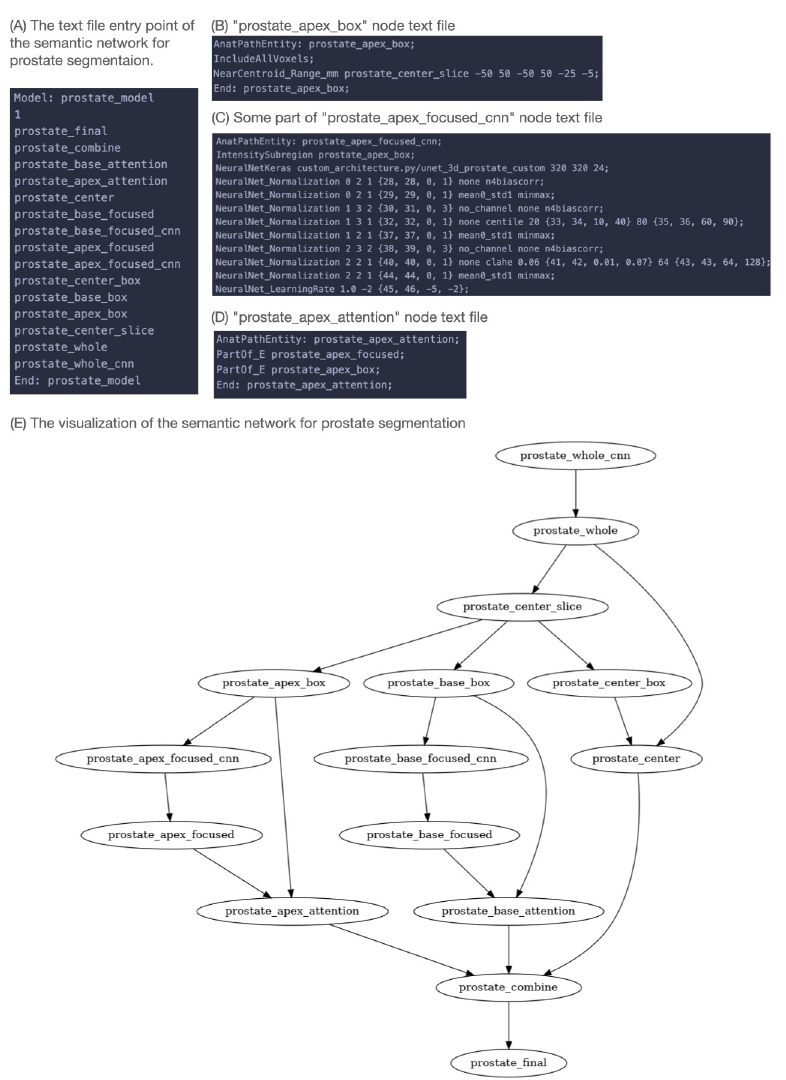
Fig 4. The SimpleMind semantic network (SN) for prostate segmentation. The SN of a Node List file listing the nodes in the SN and the corresponding set of human readable node files. (A) The prostate SN Node List file; (B) The prostate_apex_box node file; The node file is derived with the attributes for recognizing the apex area slices from the initial prediction from the prostate_whole_cnn node. (C) The prostate_apex_focused_cnn node file. (D) The prostate_apex_attention node file. (E) Graph visualization of the prostate SN.